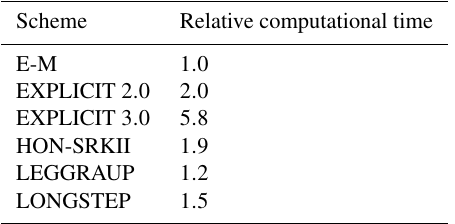
Table 4. Computational clock times, measured relative to the E-M scheme, for all of the schemes detailed in Tables 2 and 3. The calcu- lations are for N = 10 6 trajectories, with time step (cid:49)t = 10 − 3 h/u ∗ and integration time h/u ∗ . The computational times are obtained by taking the average of times elapsed in seconds from several simu- lations, coded in MATLAB, on a MacBook Pro with no other pro- grams running.